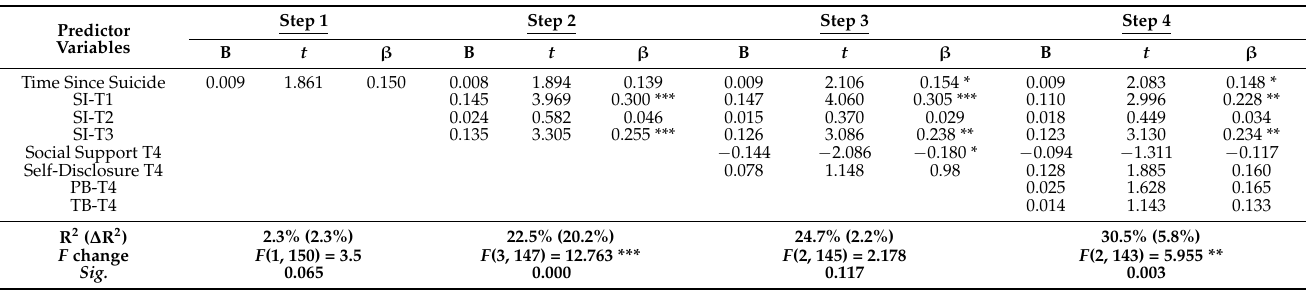
Table 3. Summary of Hierarchical Regression Coefficients of SI among SLSs by Previous SI and interpersonal variables ( N =